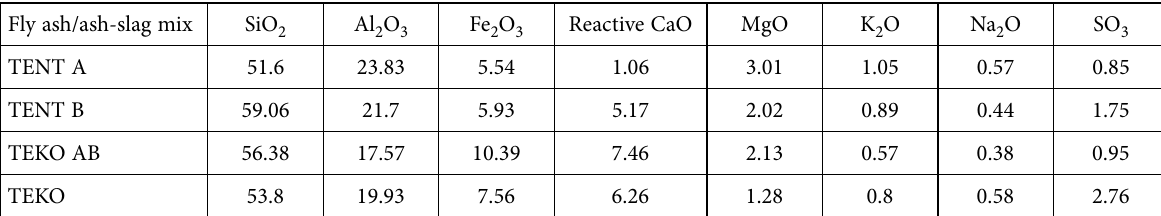
Table 5. Chemical composition of used fly ash/ash-slag mixture, mean value in the period